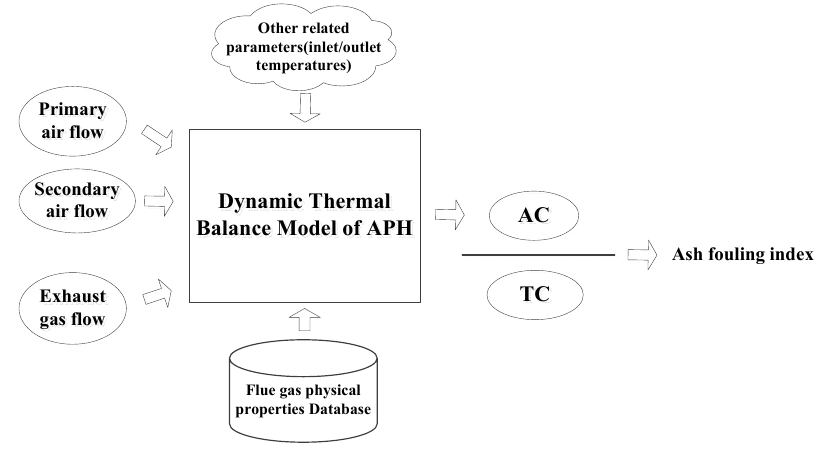
Figure 2. Schematic diagram of the monitoring model.